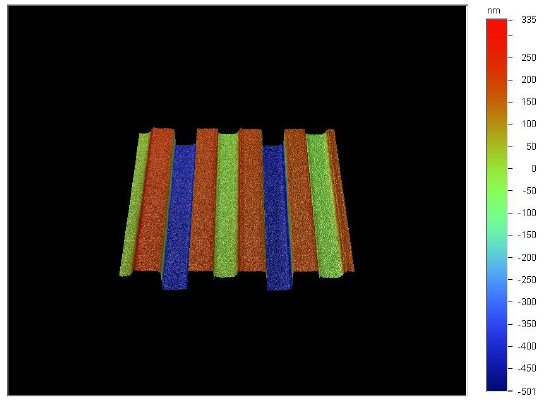
Figure 2. Measurement of the profile of the etched element using white light interference